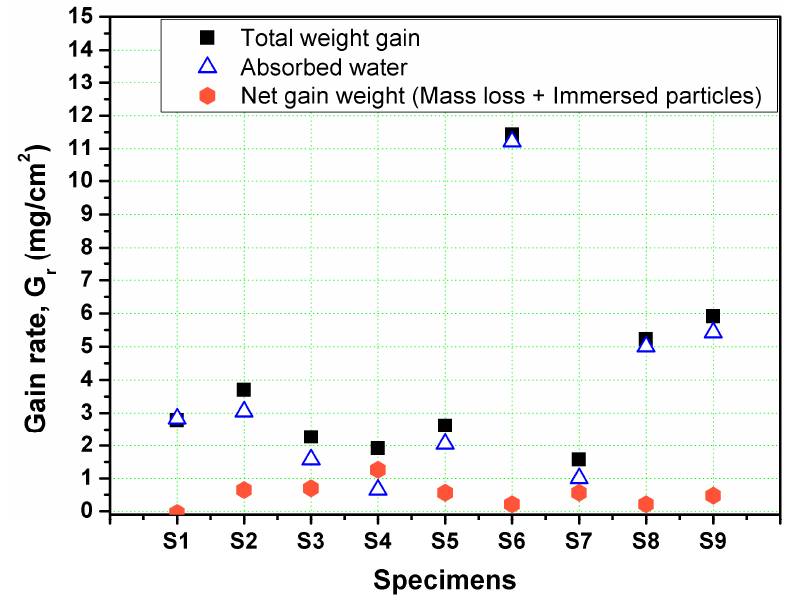
Figure 12. Gain rate in the weight of the specimens, absorbed water, and the net gain after impacting by 112.37 g of solid particles.